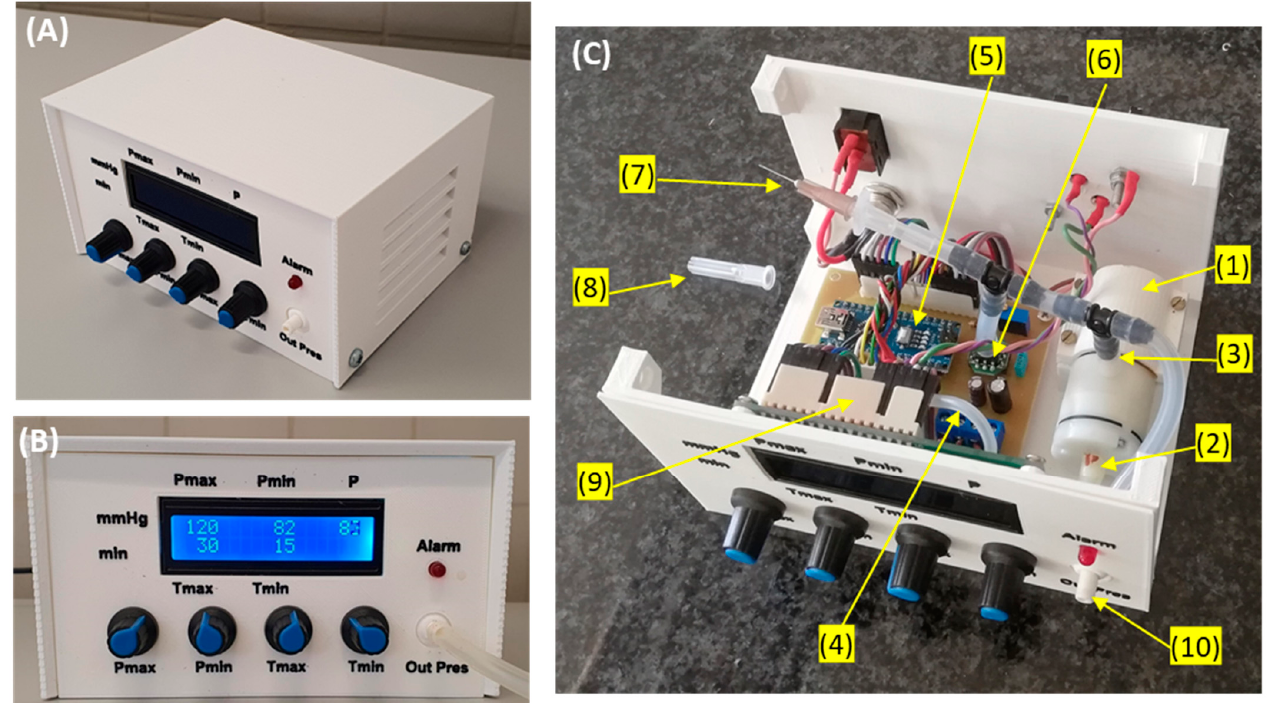
Figure 3. General ( A ) and front panel ( B ) pictures of the low-cost negative pressure device. Using knobs, the user can set the values and durations of maximum and minimum intermittent negative pressure (if these two values coincide or the time for one of the negative pressures is set to zero, constant pressure is generated). A display continuously shows the settings and the value of actual pressure (P) measured by the pressure transducer. A red-light alarm is on if vacuum pressure is outside a tolerance range. ( C ) Picture of the interior part of the device: (1) Negative pressure pump; (2): pump outlet; (3) pump inlet; (4) tube connecting room air with the pump outlet; (5) Arduino controller; (6): pressure transducer; (7): orifice (needle) open to room air; (8): perforated needle protector (for clarity, not in its place in this picture); (9) display; (10) negative pressure port of the device. See text for details.